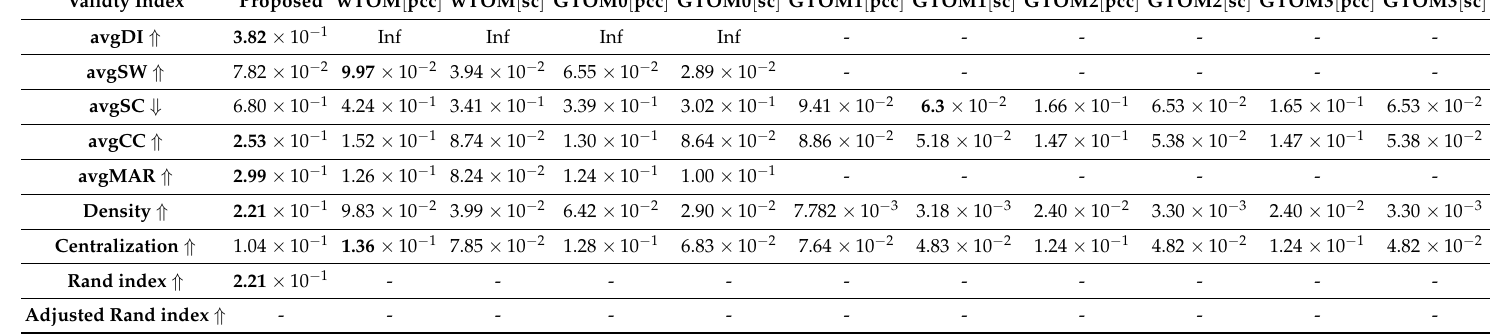
Table 3. Comparison of proposed rule-based gene-module detection method and other existing geneset-based gene-module detection methods for the LUSC dataset. Validty Index